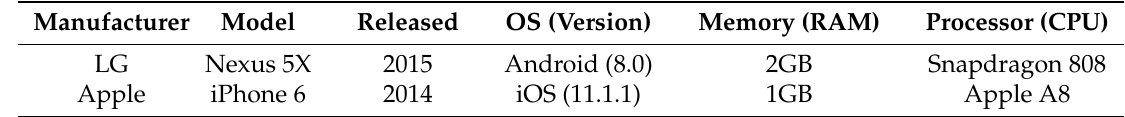
Table 2. List of Mobile Devices